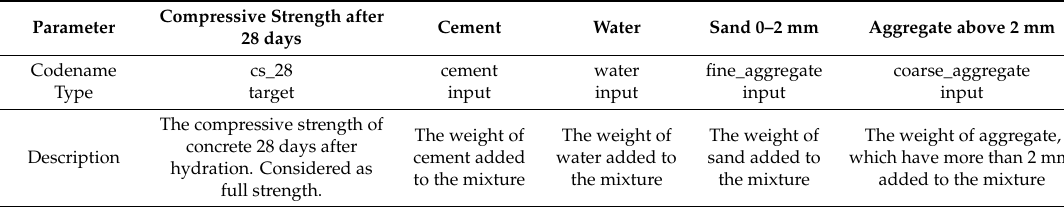
Table 1. The parameters adopted in the dataset.